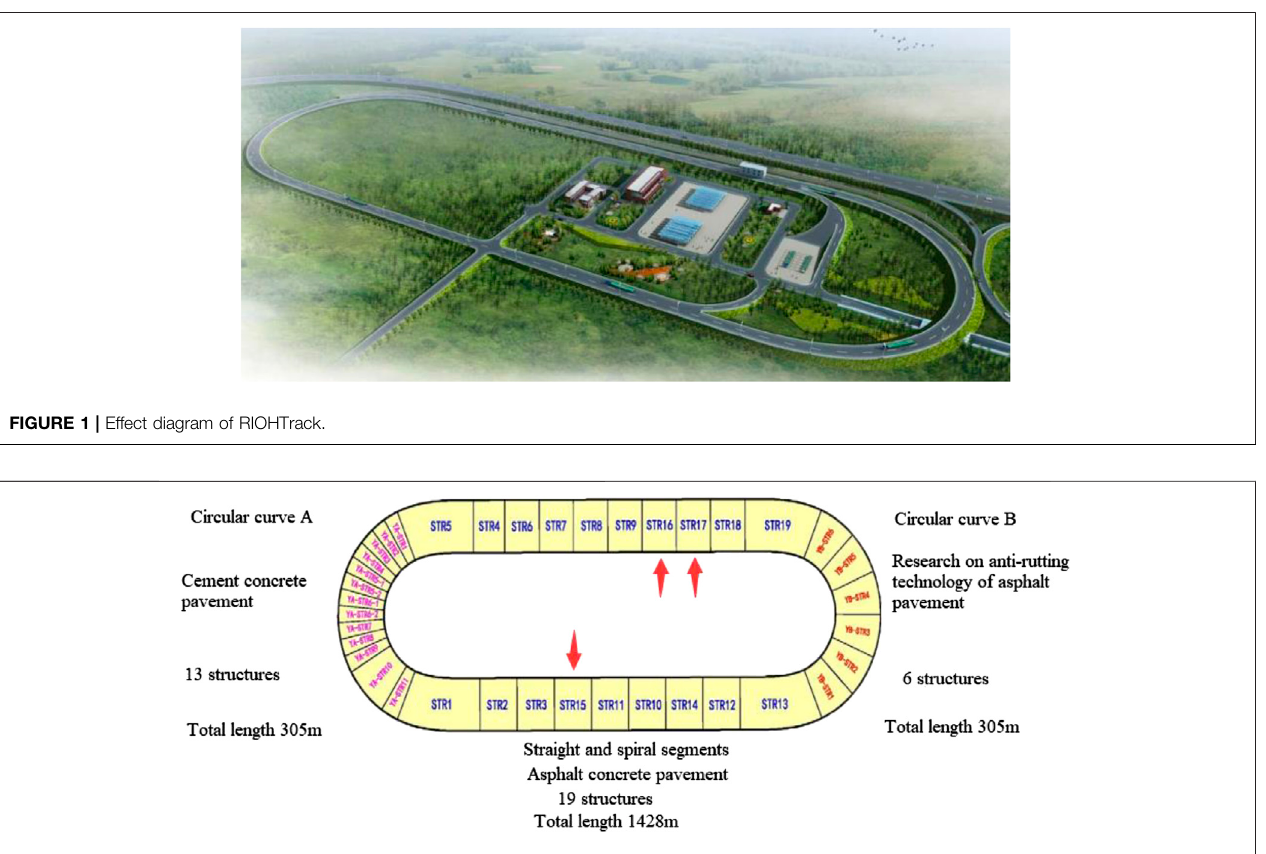
FIGURE 2 | Structural layout drawing of RIOHTrack.